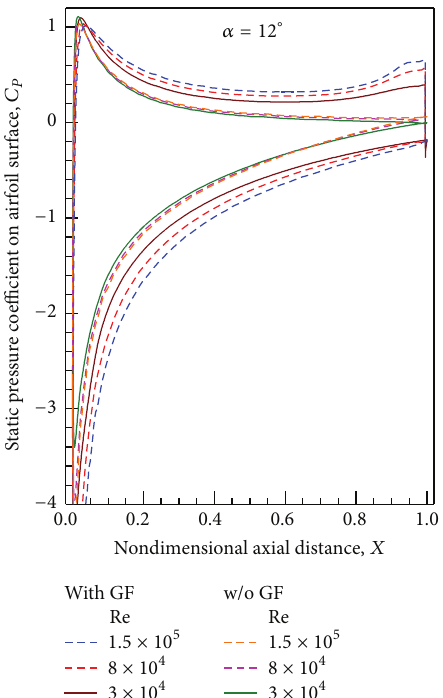
Figure 7: Variation of lift-to-drag ratio with Reynolds number for the airfoil without and with GF.